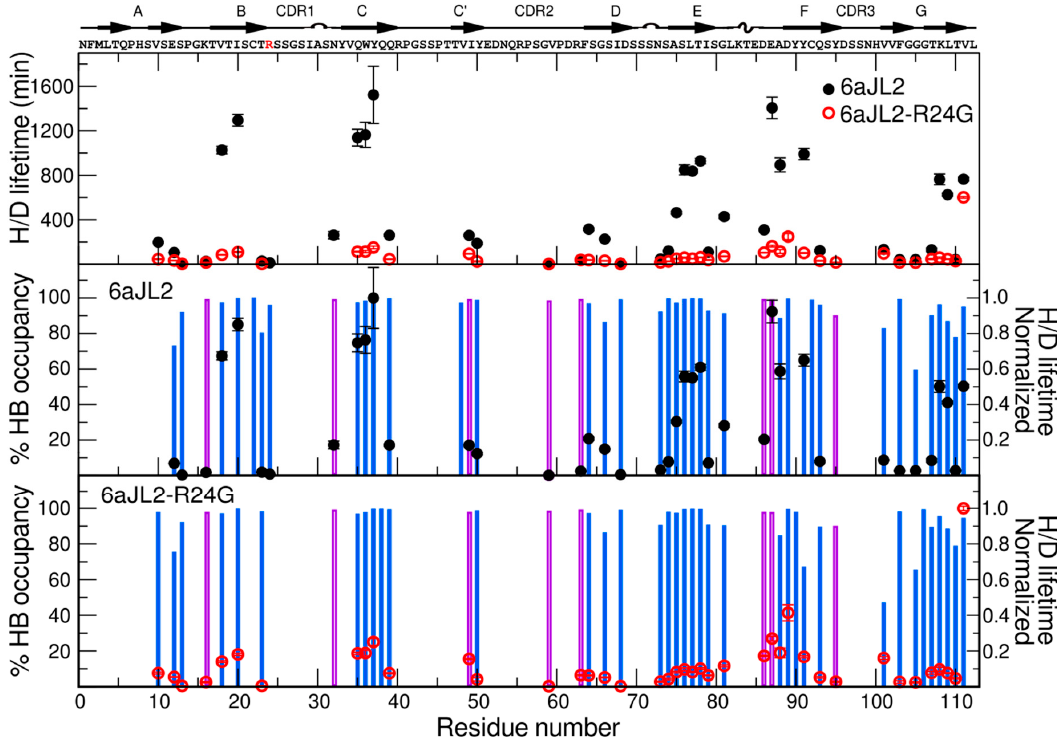
Figure 4. Hydrogen deuterium mean exchange lifetime values compared to hydrogen bond occupancies. Top panel: Experimental Hydrogen deuterium (H/D) exchange lifetimes reflecting the slow motions of 6aJL2 (black) and 6aJL2-R24G (red). Middle panel: Percentage of backbone N − H hydrogen bond occupancy calculated from MD simulations (blue bars). Black circles represent the normalized H/D lifetimes for 6aJL2. Purple bars represent the percentage of buried residue from 0 Å exposed (100% buried) to 10 Å exposed (0% buried). Bottom panel: Percentage of backbone N − H hydrogen bond occupancy calculated from MD simulations (blue bars). Red circles represent the normalized H/D lifetimes for 6aJL2-R24G. Purple bars represent the percentage of buried residue from 0 Å exposed (100% buried) to 10 Å exposed (0% buried). The protein sequence and secondary structure elements are indicated above the top panel. The mutation site is shown in red.